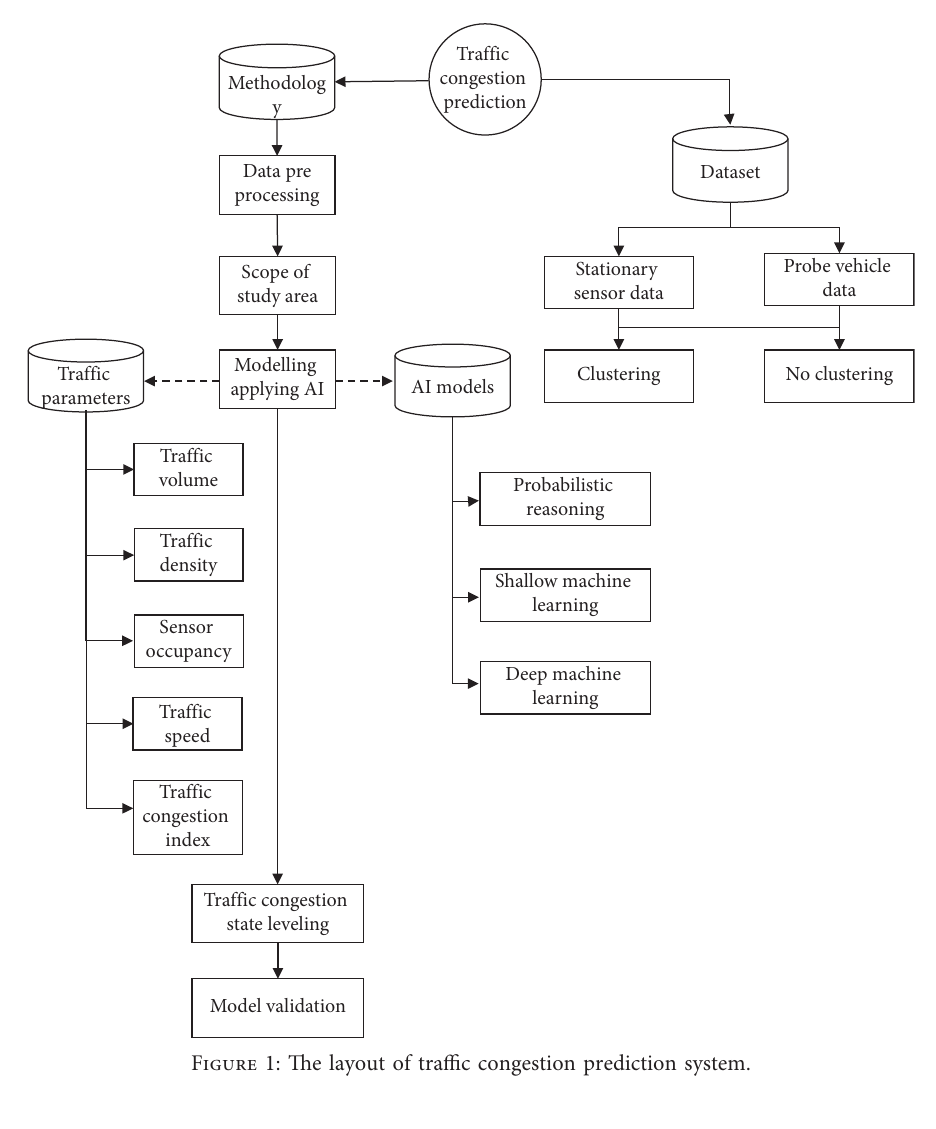
Figure 1: The layout of traffic congestion prediction